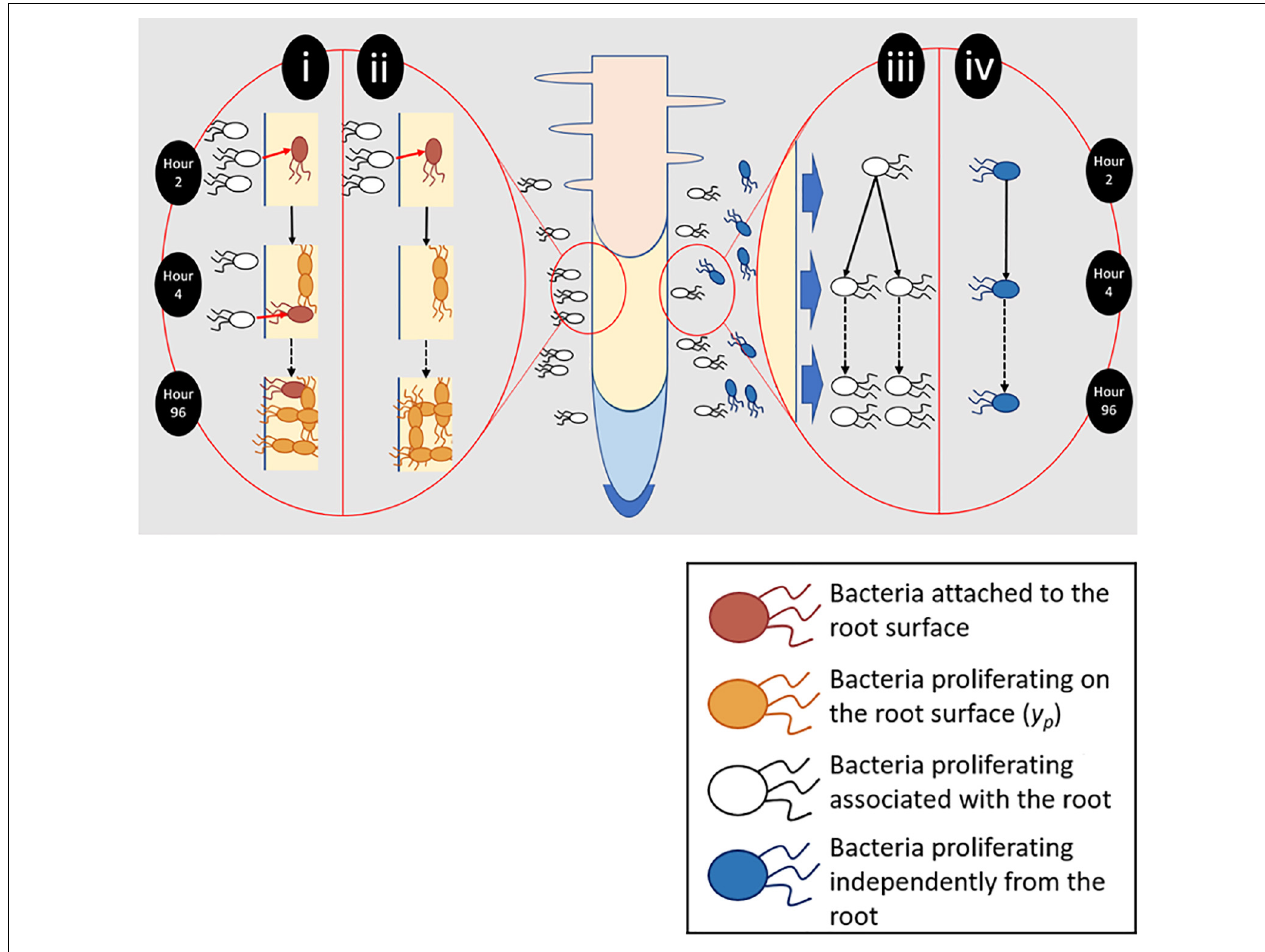
FIGURE 2 | Different aspects of root surface colonization were experimentally isolated and quantified. (i) Total bacterial numbers on the root surface (y c ) were the result of bacterial attachment (pink) and proliferation (orange). (ii) To quantify proliferation on the root surface (y p ), plants were transferred to sterile microcosms 2 h after inoculation. Sterile microcosms contained no bacteria in suspension (white) and as a result attachment could not occur. (iii) Bacteria proliferating in the presence of the root and root exudate were quantified. (iv) The ability of bacteria to proliferate in the absence of any root input was also